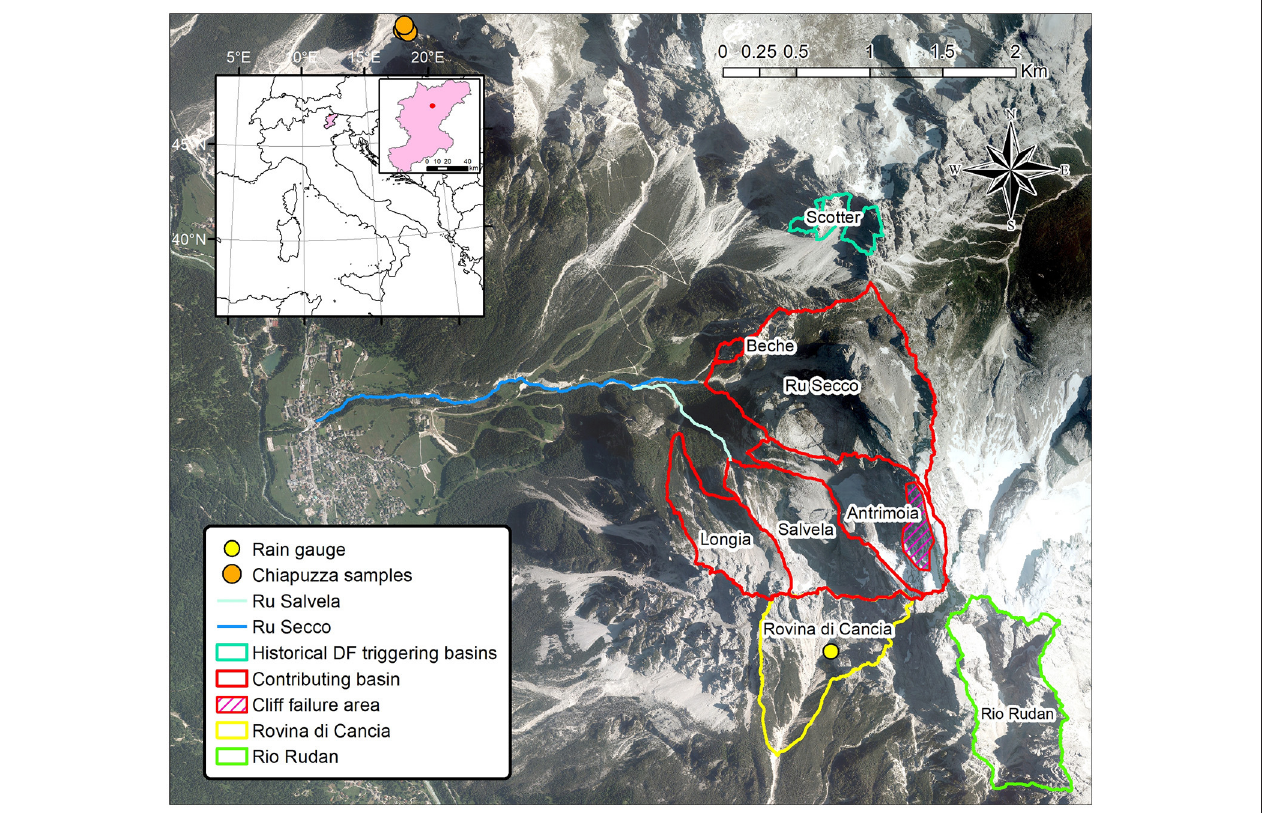
FIGURE 1 | Aerial view of whole area with the contributing hydrological basins and the basins of Rovina di Cancia and